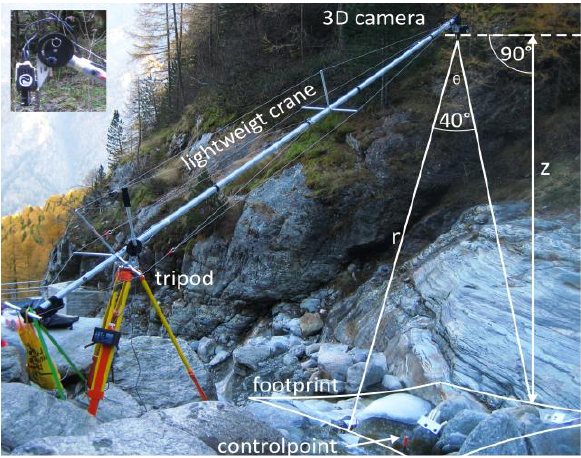
Figure 1 crane with mounted camera over streambed.